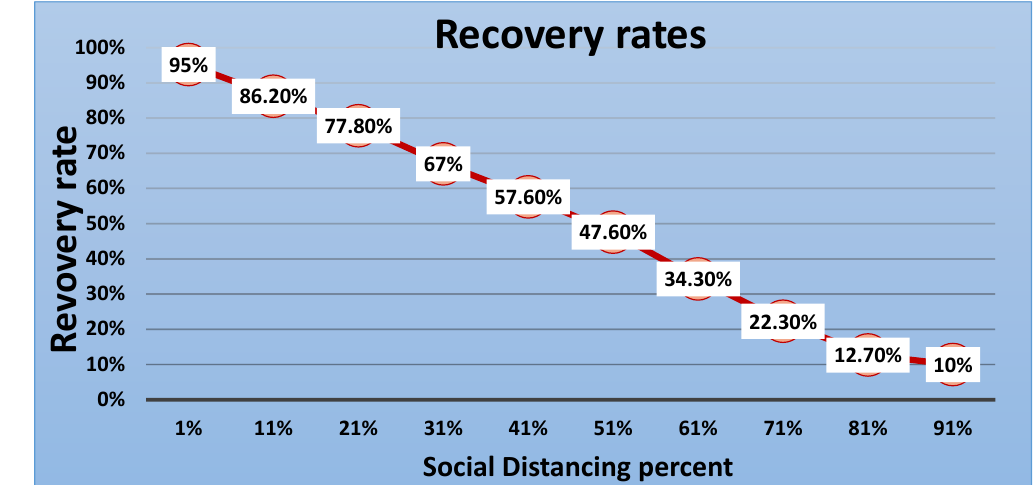
Figure 18. Number of deaths versus percentage of social distancing.